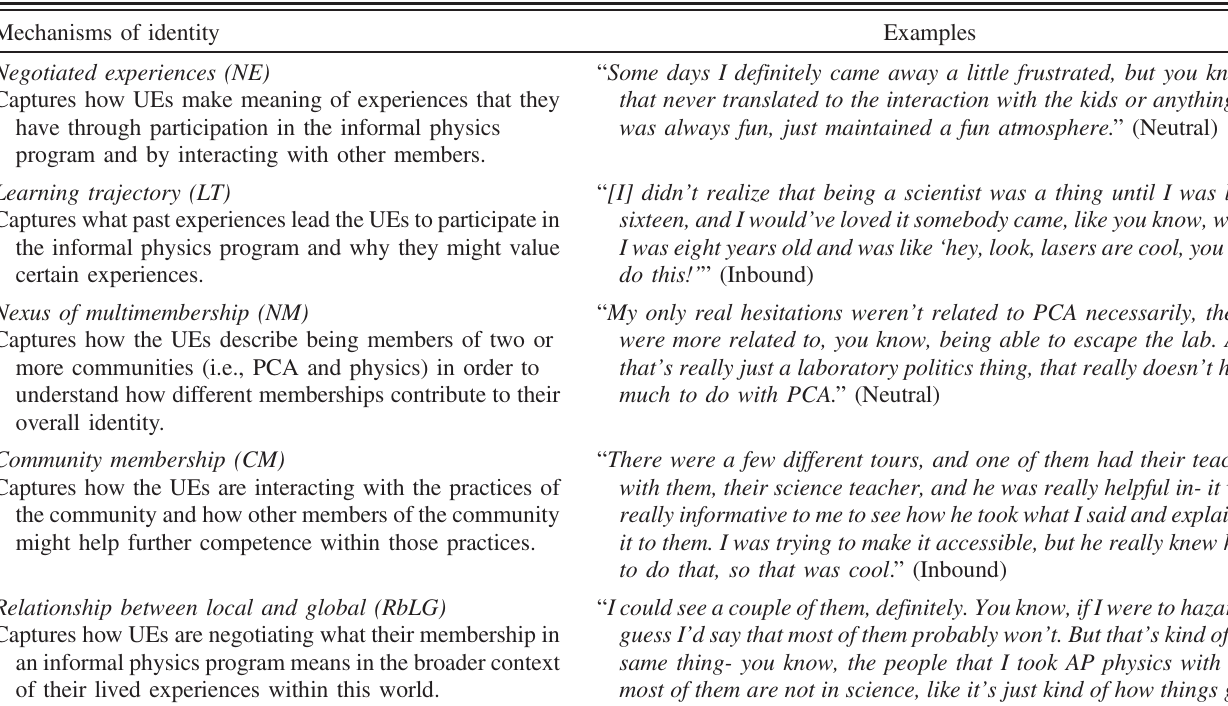
TABLE II. Description and examples of the mechanisms of identity